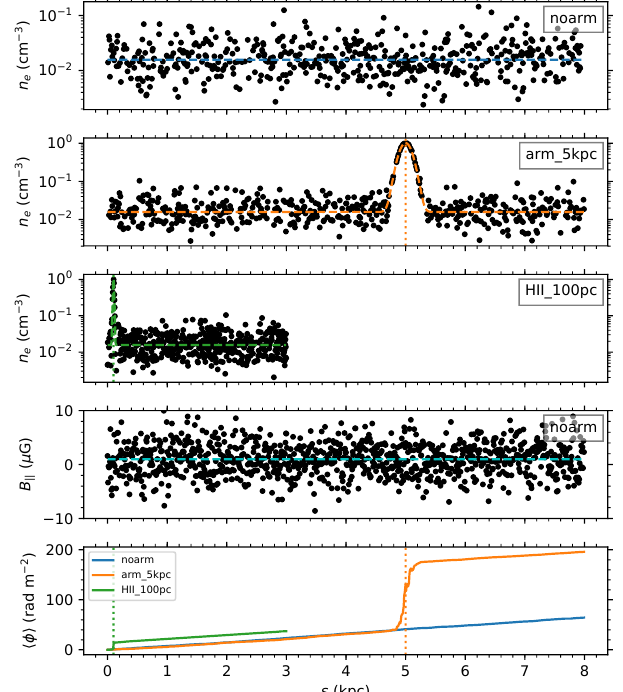
Figure 1. Input density along the line of sight for one sightline in each model, with parameters listed in Table 1. The “beam” in a given model consists of N sightlines, each chosen from the same distribution, as shown here. The fourth panel shows the line-of-sight component of the magnetic field for one model. Points show the individual cells; dashed lines show the median; vertical dotted lines show the position of the arm in each model. The bottom panel shows the mean Faraday depth across all the sightlines in each